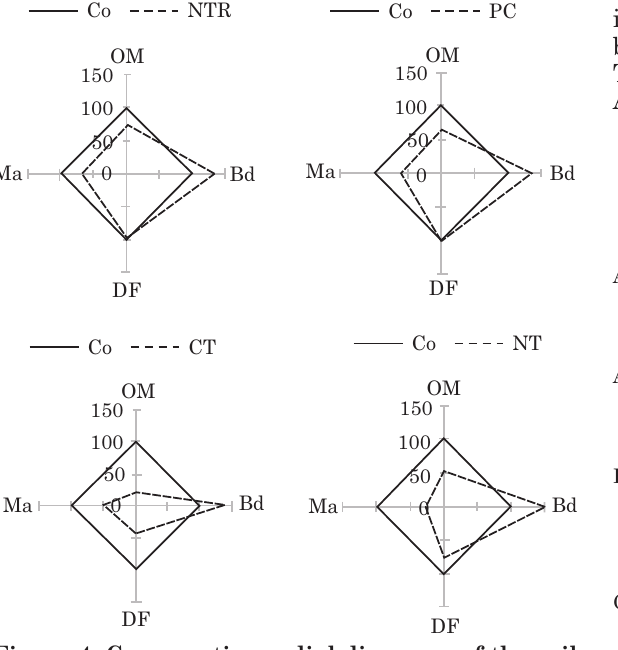
Figure 4. Comparative radial diagrams of the soil quality under the different management systems (NTR: no-tillage crop rotation; PC: perennial crop; CT: conventional tillage and NT: no-tillage without crop rotation ), considering the values obtained for the layer of 0-50 cm of soil organic matter content (OM), bulk density (Bd), degree of soil flocculation (FD) and soil macroporosity